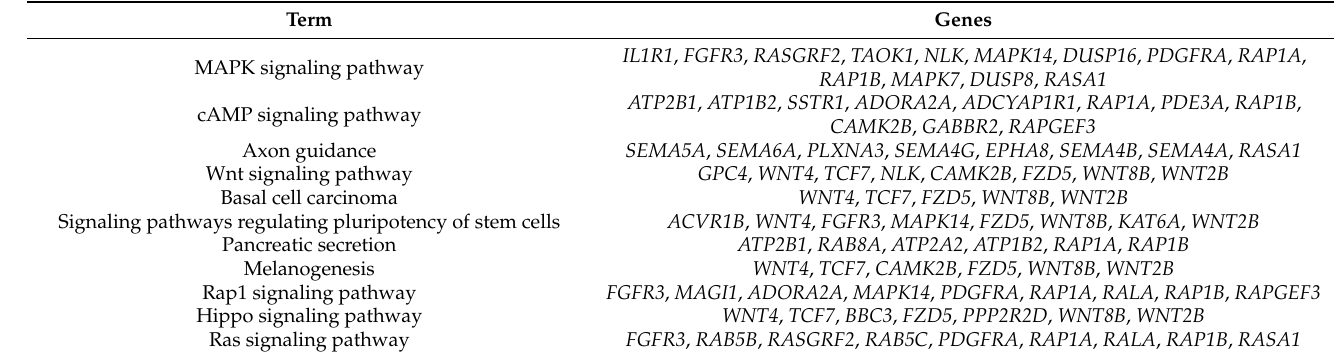
Figure 4. Prediction of miR-24-3p target genes in different species. ( A ) Venn analysis of the target genes of miR-24-3p in cattle, mice, and humans, and rat. ( B ) Venn analysis of the target genes of miR- 24-3p in cattle and rat species. ( C ) GO analysis of the common target genes of rat mmu-miR-24-3p and cattle bta-miR-24-3p. Table 1. KEGG analysis of the common target genes of mmu-miR-24-3p and